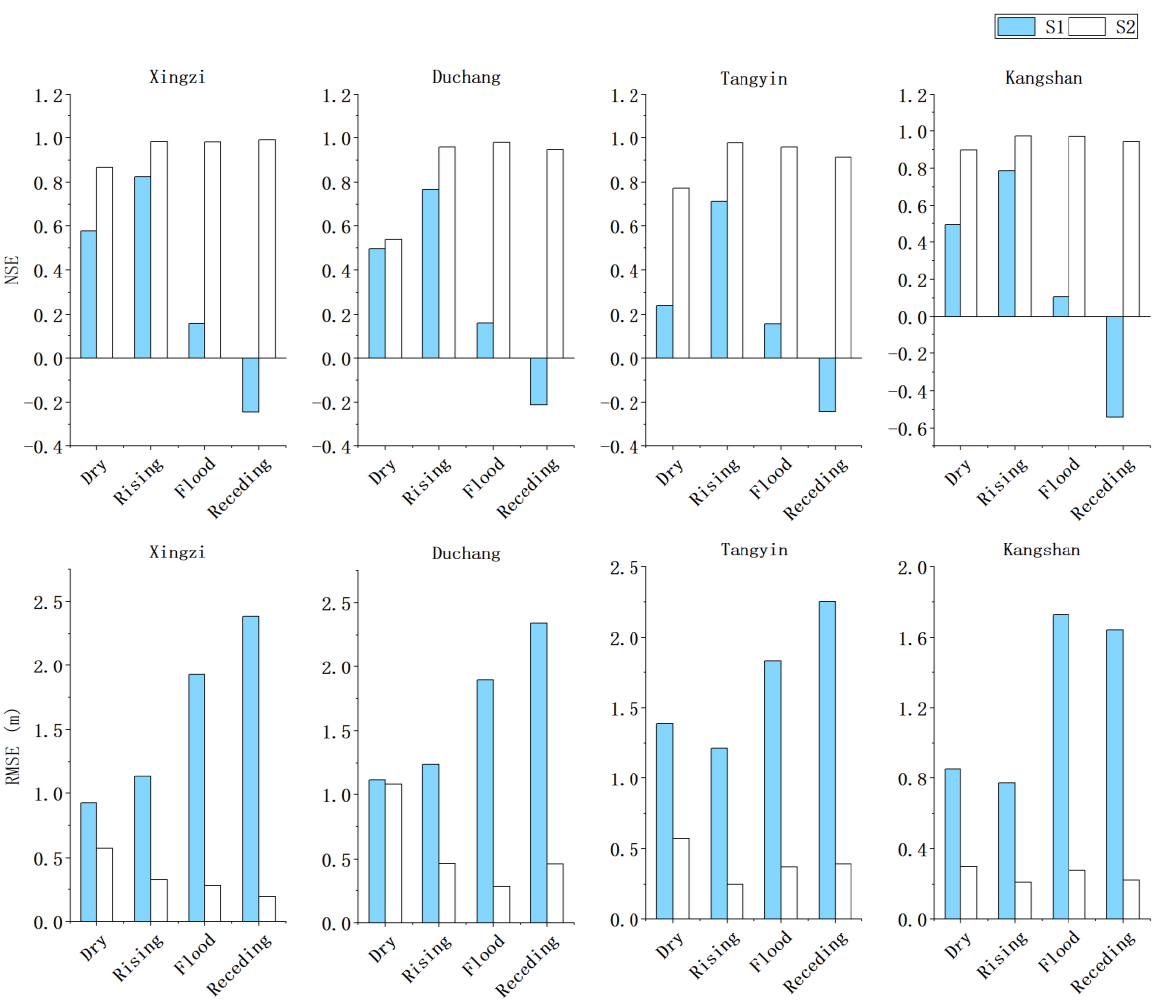
Figure 6. NSE and RMSE values in four periods under S1 and S2.